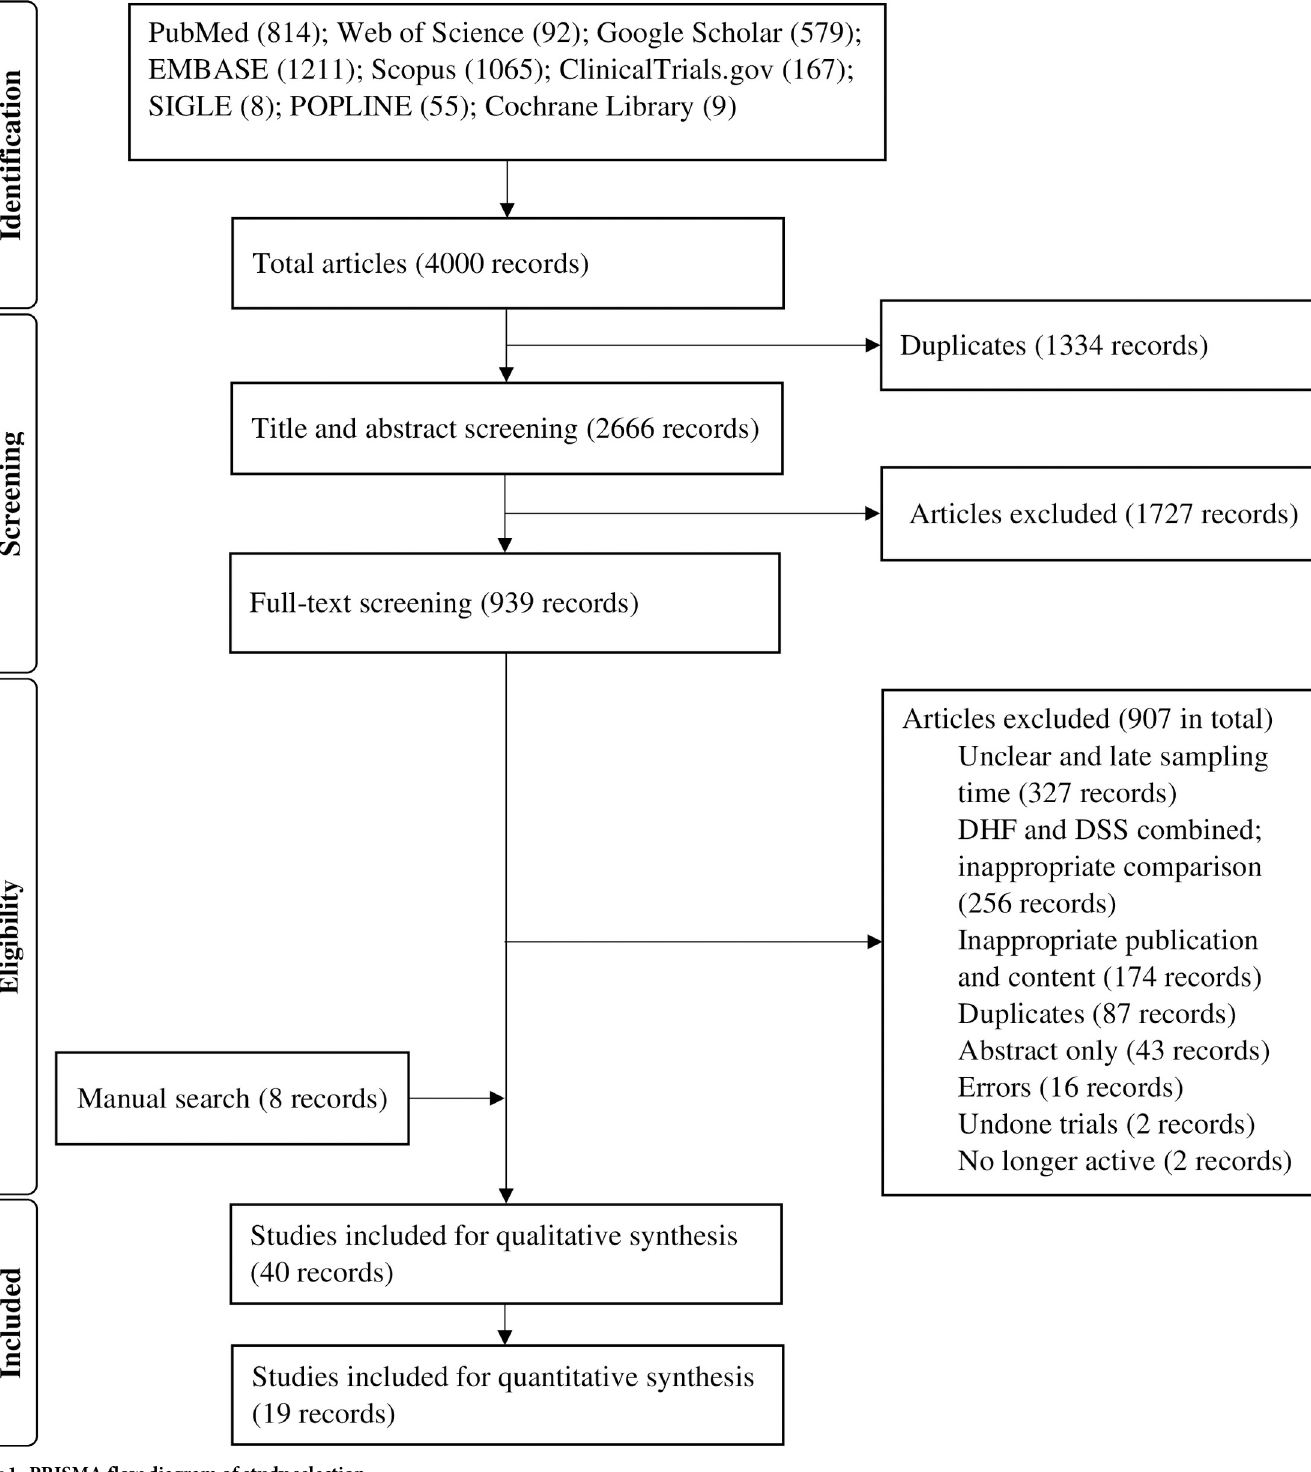
Fig 1. PRISMA flow diagram of study